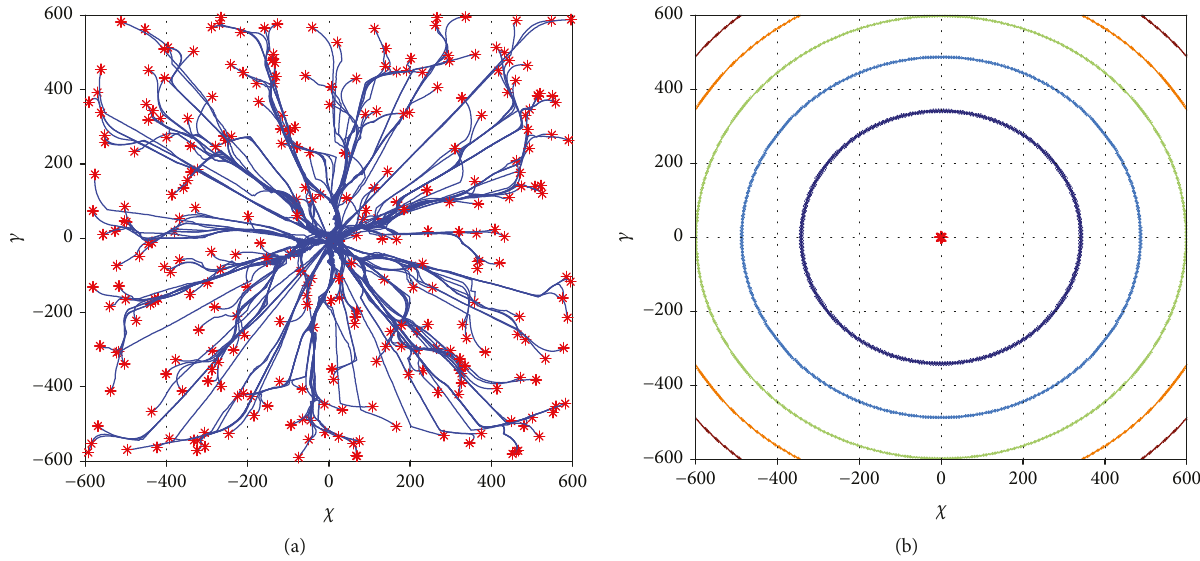
Figure 3: Iterative trajectories and the fi nal distribution of butter fl ies of the function f (b) the fi nal distribution of butter fl ies by